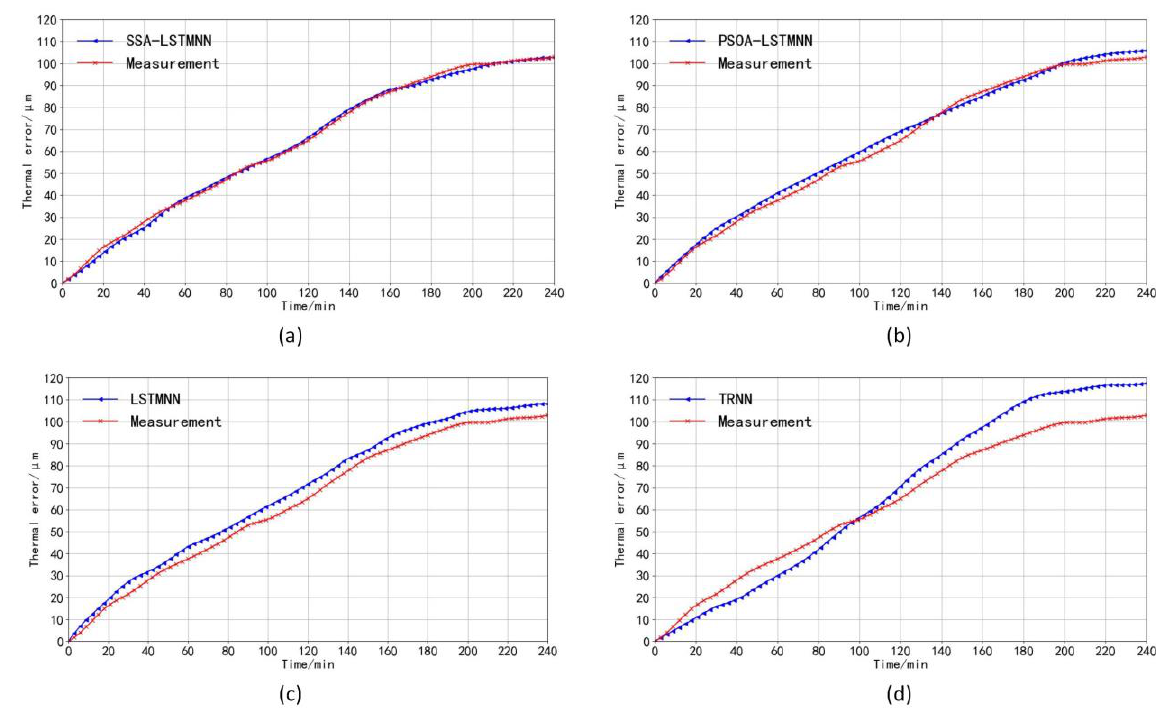
Figure 19. The prediction curve of each model at the speed of 8000 mm/min compared with the measured curve: ( a ) SSA-LSTMNN model, ( b ) PSOA-LSTMNN model, ( c ) LSTMNN model, and ( d ) TRNN model.